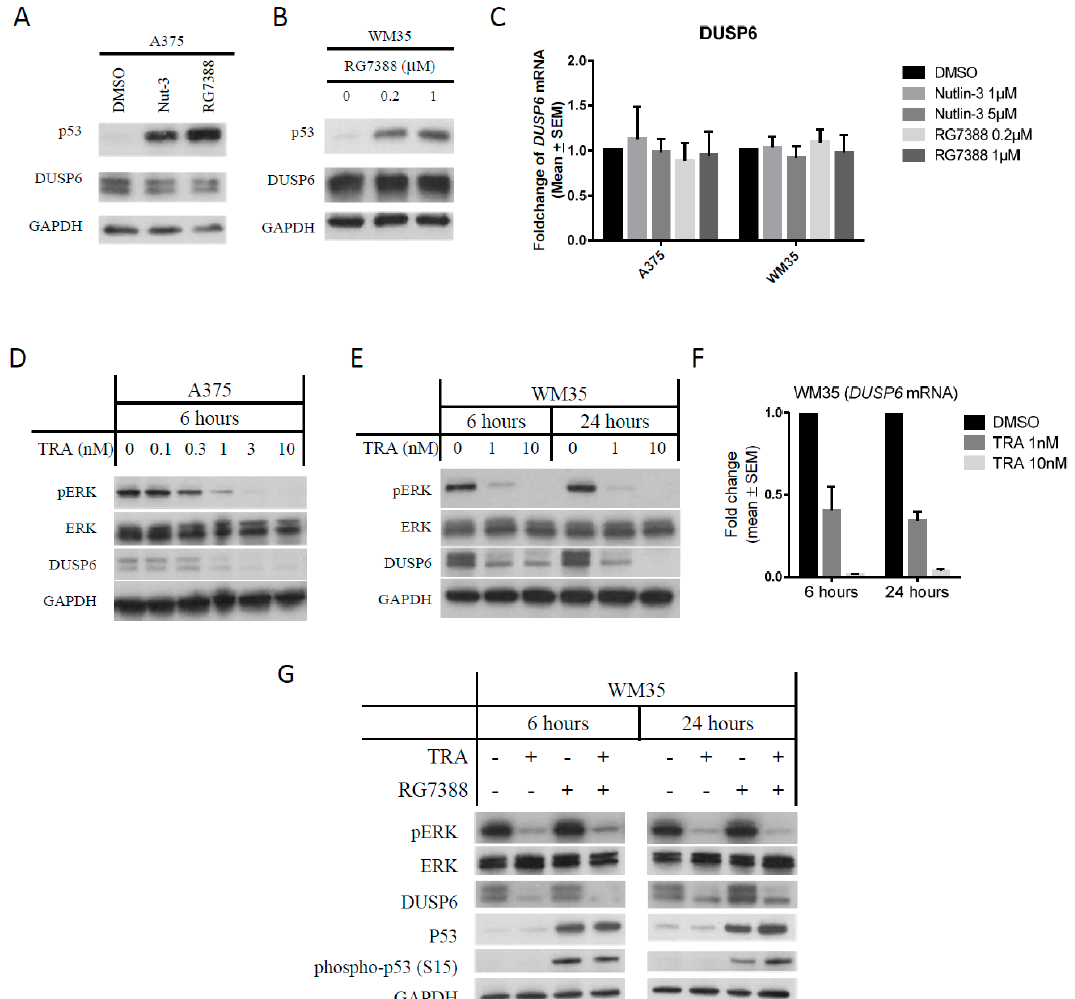
Figure 4. DUSP6 was regulated by pERK and not by p53. ( A ) Immunoblotting of A375 treated with nutlin-3 (5 µ M) and RG7388 (1 µ M) for 6 h. ( B ) Immunoblotting of WM35 treated with RG7388 (0.2 and 1 µ M) for 6 h. ( C ) DUSP6 mRNA in A375 and WM35 treated with the indicated concentrations of nutlin-3 and RG7388 for 6 h, measured by qRT-PCR. ( D , E ) Immunoblotting of A375 ( D ) and WM35 ( E ) treated with trametinib for the indicated concentrations and times. ( F ) Changes of DUSP6 mRNA by qRT-PCR in WM35 treated with trametinib. ( G ) Immunoblotting of WM35 treated with trametinib (1 nM) and/or RG7388 (0.2 µ M) for 6 and 24 h. TRA, trametinib.